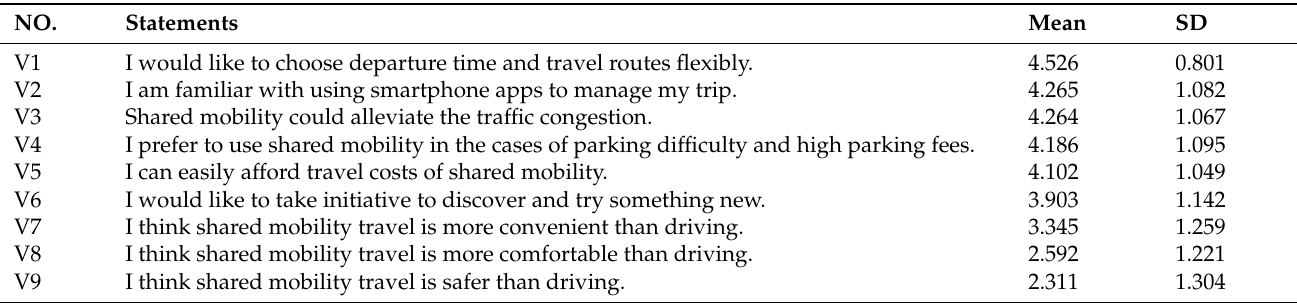
Table 3. Statistics of attitudinal